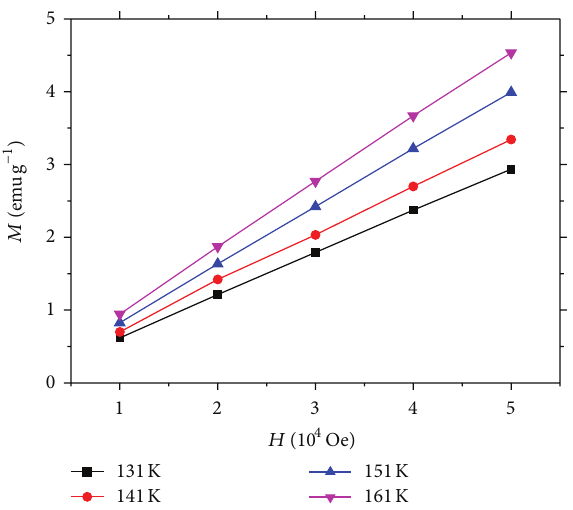
Figure 3: Magnetization versus magnetic field 𝑀 versus 𝐻 at several temperature around 𝑇